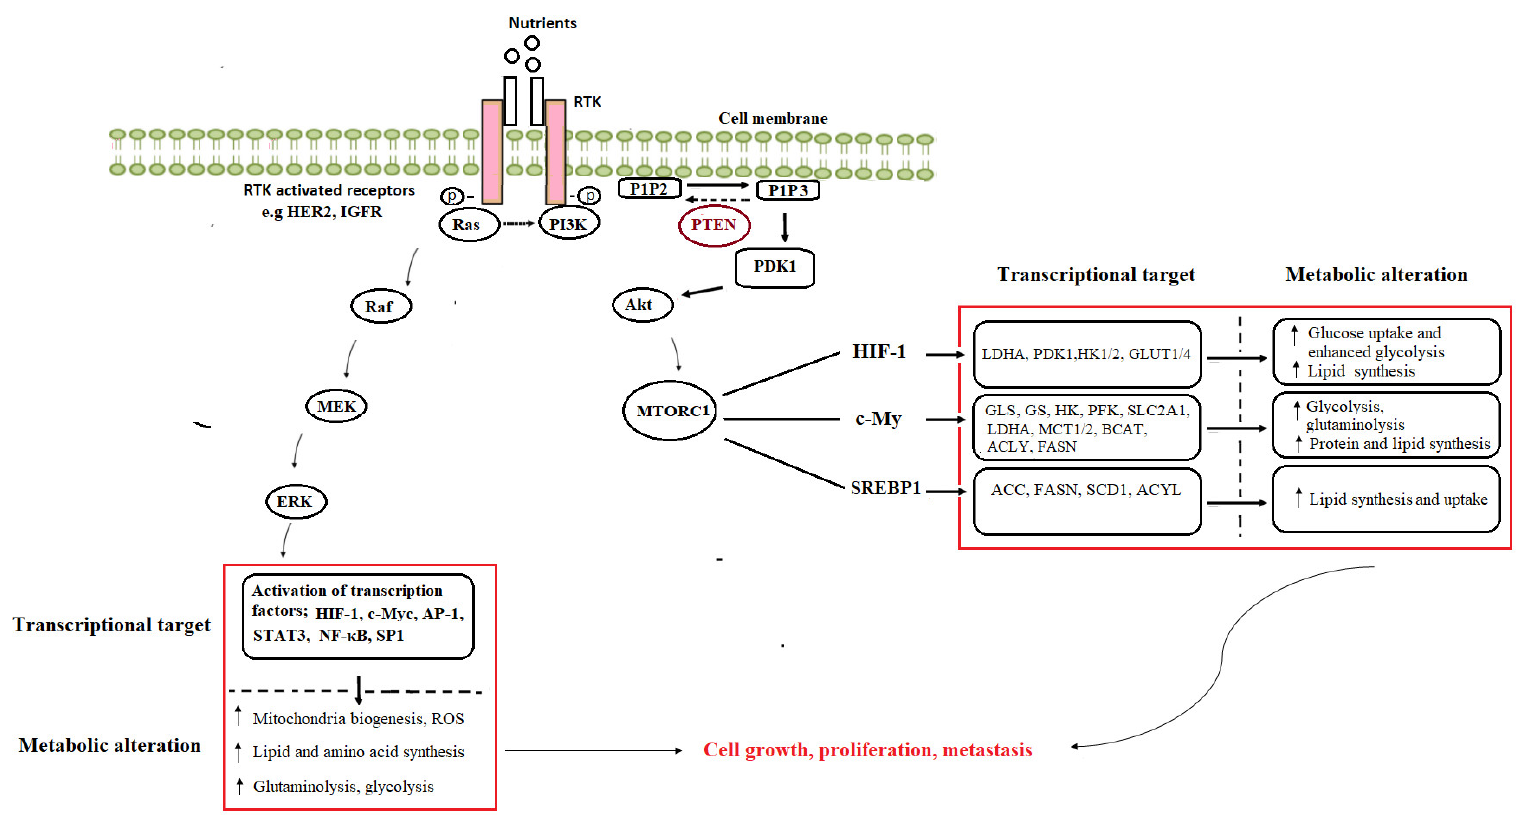
Figure 2. The oncogene-induced activation of metabolic pathways in cancer. GLS—glutaminase, GS—glutamine synthetase, HK—hexokinase, LDHA—lactate dehydrogenase A, MCT—monocarboxylate transporter, PDHK—pyruvate dehydrogenase kinase, SLC—solute carrier family, PFK—phosphofructokinase, GLUT—glucose transporter, ACC—